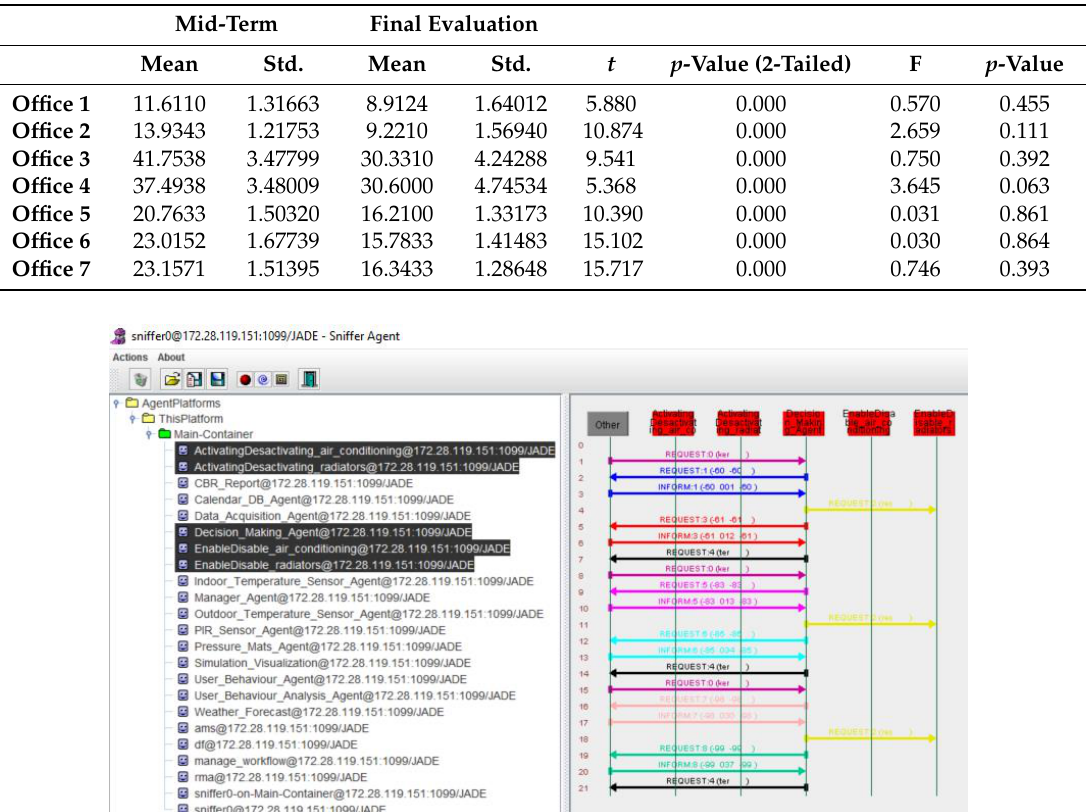
Figure 12. Communication between the agents in the decision-making process.